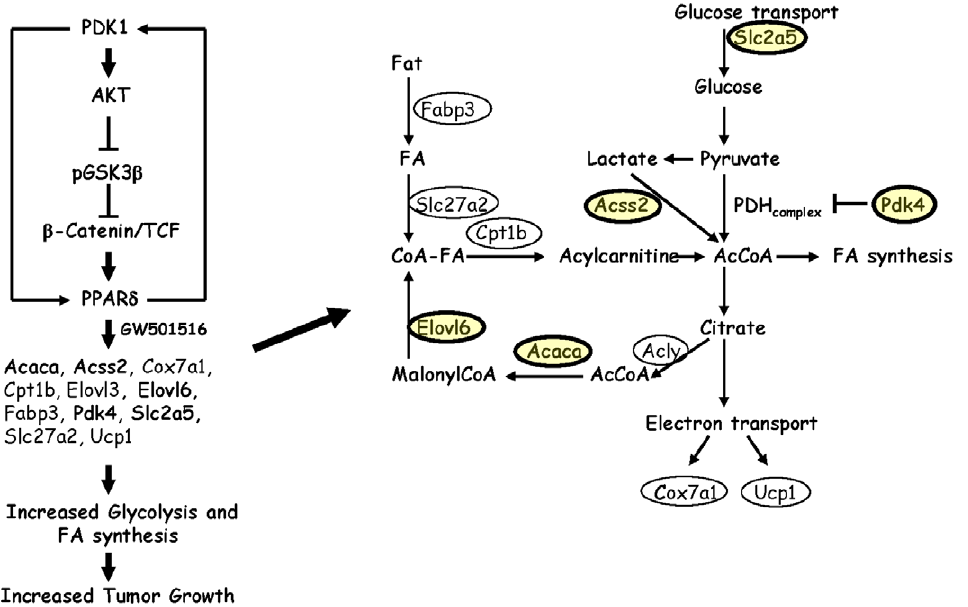
Figure 5. Schematic of the regulation of glucose and fatty acid metabolism by PDK1 and PPAR d . One mechanism depicted is that PPAR d upregulates PDK1 expression and activates AKT to inhibit GSK3 b and increase b -catenin/TCF-dependent transcription; however, it is controversial whether PPAR d is a TCF target gene. Activation of PPAR d by GW501516 in wild-type and MMTV-PDK1 mice upregulates the expression of genes (highlighted in yellow ) associated with glucose transport (Slc2a5), acetylCoA formation through acetylCoA (Acss32, Pdk4), and fatty acid biosynthesis (Acaca, Elovl6). Genes associated with fatty acid transport and transcriptional regulation (Fabp3), formation of acetylCoA from citrate (Acly), fatty acid transport (Cpt1b), CoA fatty acid esters (Slc27a2) and increased oxidative phosphorylation (Cox7a1 and Ucp1) are increased by GW501516 in wild- type mice and in untreated PDK1 transgenic mice, but do not correlate with GW501516-induced tumorigenesis. HDAC, histone deacetylase; FA, fatty acid; PDH, pyruvate dehydrogenase; inhibition.